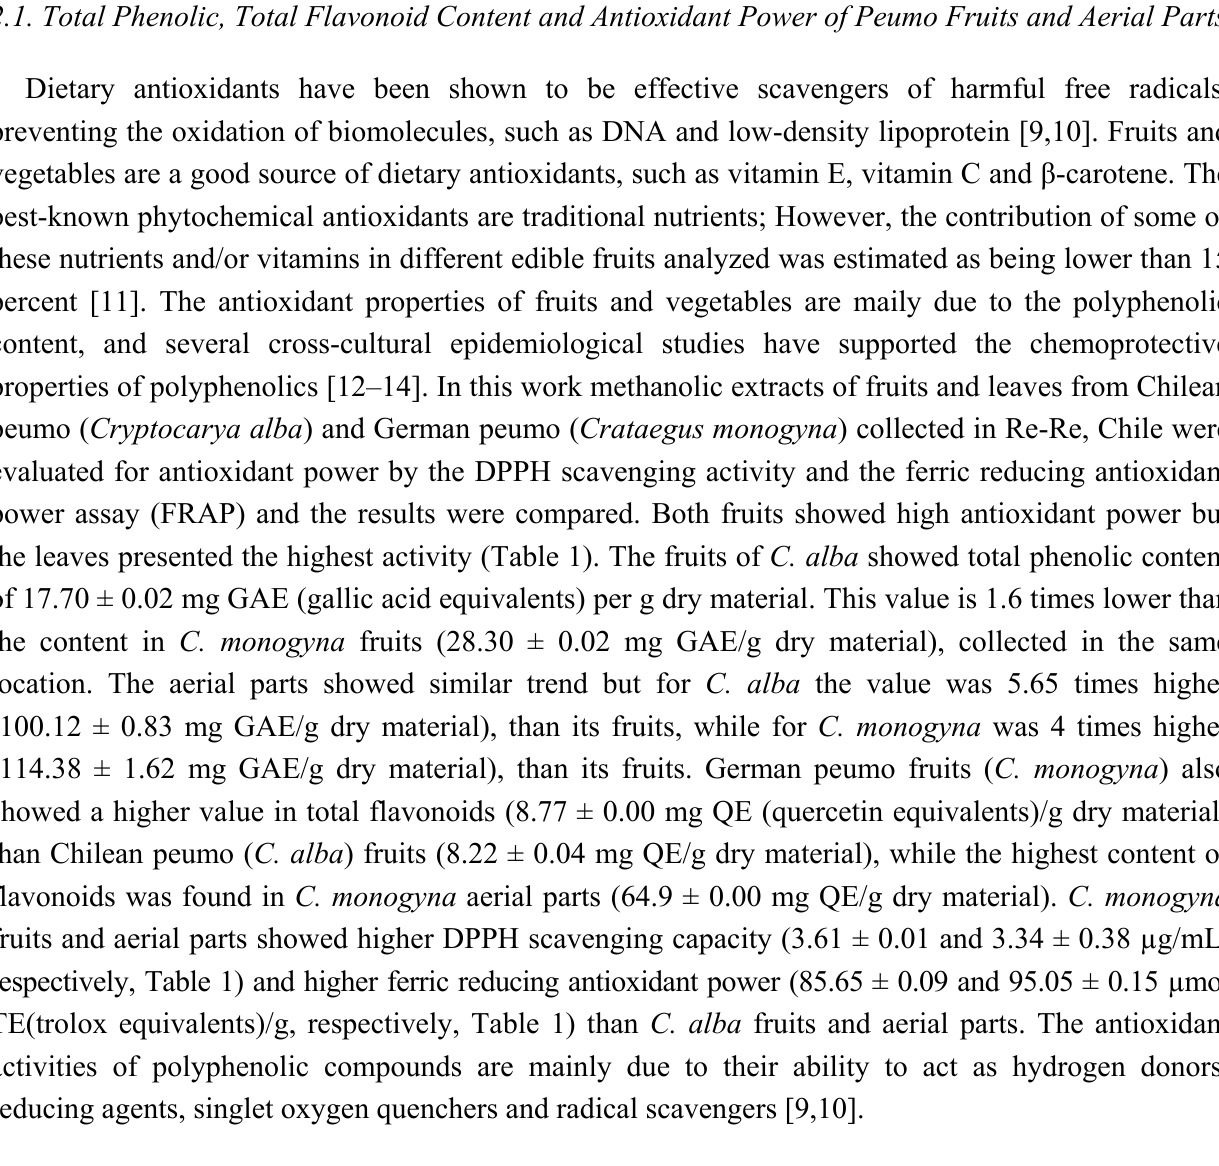
Table 1. Total phenolic content (TPC), total flavonoid content (TFC) and ferric reducing antioxidant power (FRAP), scavenging of the free radical DPPH and percent w/w extraction yield of peumo methanolic extracts on the basis of freeze-dried starting material. Species and plant part